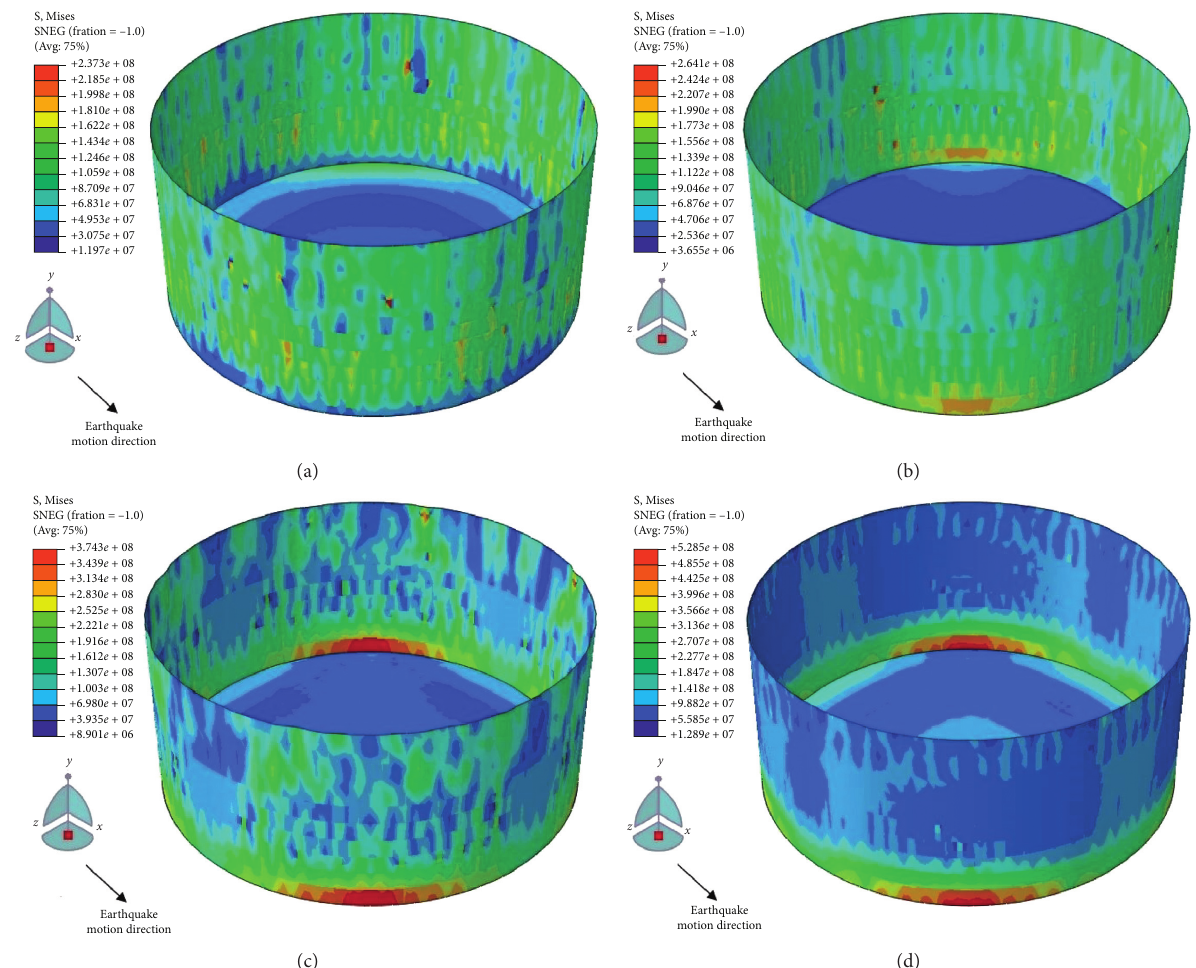
Figure 11: The maximum von Mises stress distribution of the inner tank under different LNG liquid levels. (a) At 25% full, (b) at 50% full, (c) at 75% full, and (d) at 100%